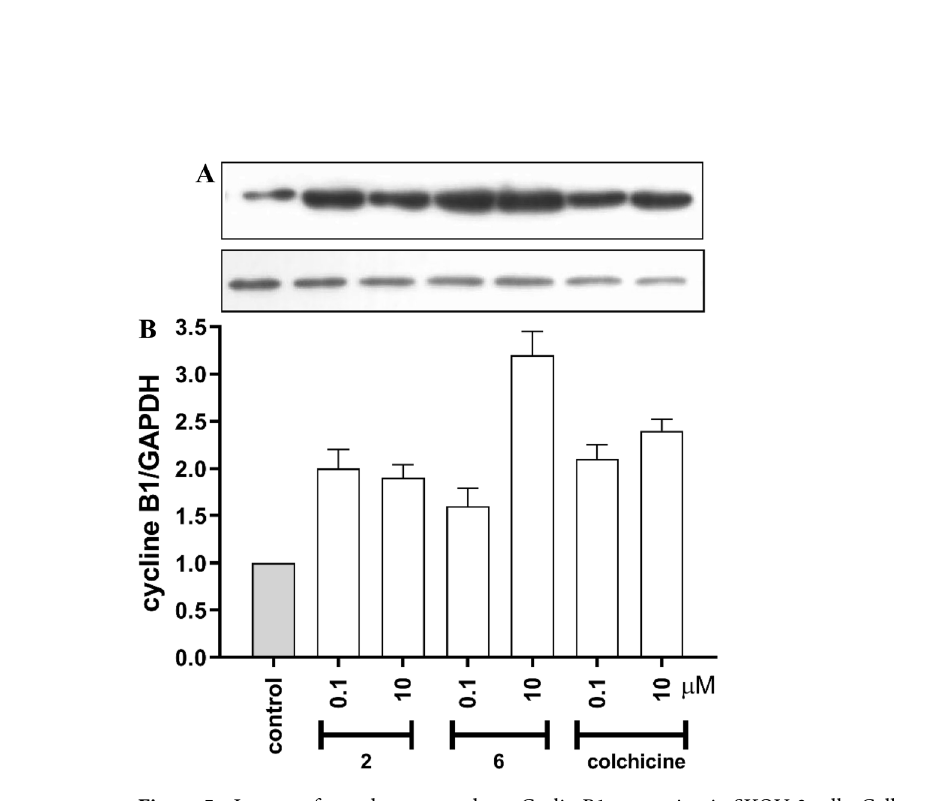
Figure 5. Impact of tested compounds on Cyclin B1 expression in SKOV-3 cells. Cells were treated with tested compounds: colchicine, 2 and 6 at concentrations 0.1 μM, 10.0 μM for 24 h. All tested groups were significantly different from control group, p < 0.001 ( A ) Western blot, ( B ) corresponding results of densitometric